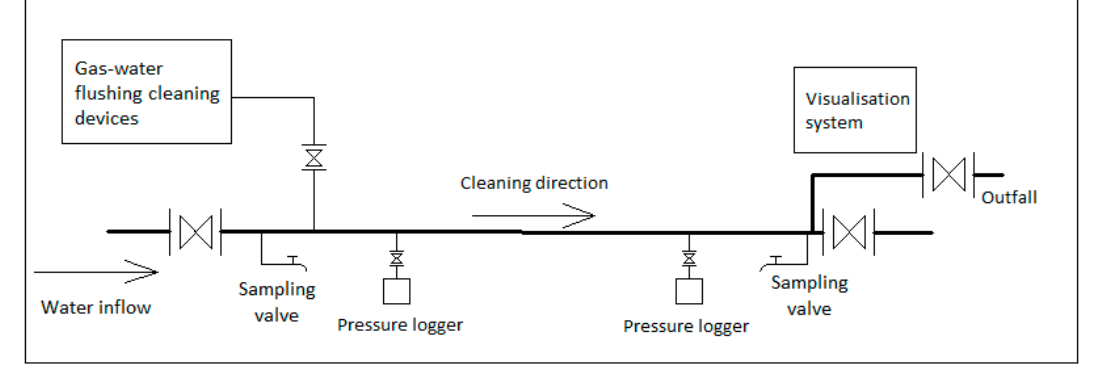
Figure 30. Diagram of the two-phase (gas and water) flushing process.